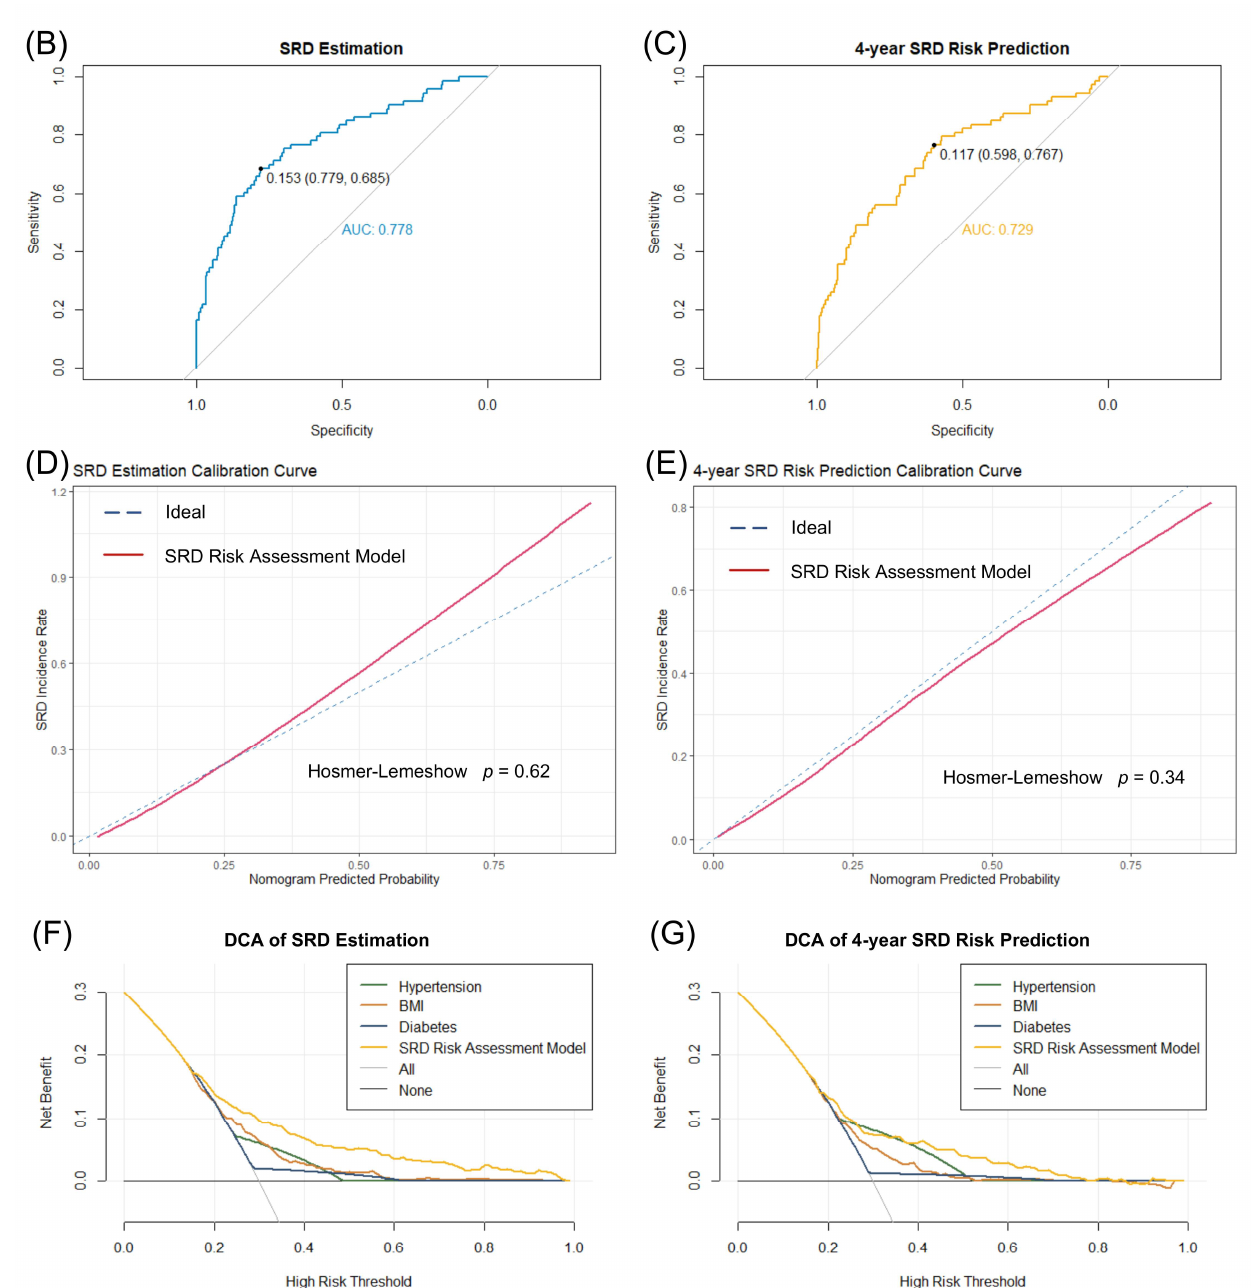
Figure 3. SRD risk assessment model construction and validation. ( A ) Nomogram for SRD risk. Diagnostic possibility can be calculated based on SBP, DBP and BMI. ( B , C ) AUC value of the ROC curve in the internal validation set. The SRD estimation AUC value can reach 0.778 and the 4-year SRD risk prediction AUC value can reach 0.729. ( D , E ) Calibration analysis for this SRD risk assessment model. ( F , G ) Decision curve analysis for hypertension, diabetes, BMI and this SRD risk assessment model, which showed this model had greater potential clinical benefits than each individual variable used to assess SRD risk in current clinical practice such as hypertension, diabetes and BMI. SRD, subclinical renal damage; SBP, systolic blood pressure; DBP, diastolic blood pressure; BMI, body mass index; AUC, area under the curve; DCA, decision curve